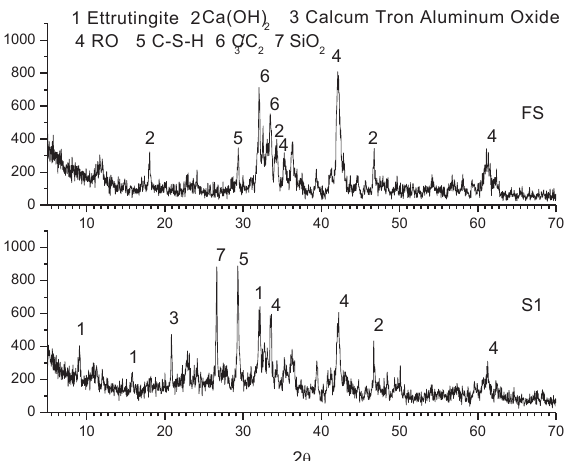
Figure 5: XRD analysis of S1 hydration products at 3 days (FS is original steel slag powder).